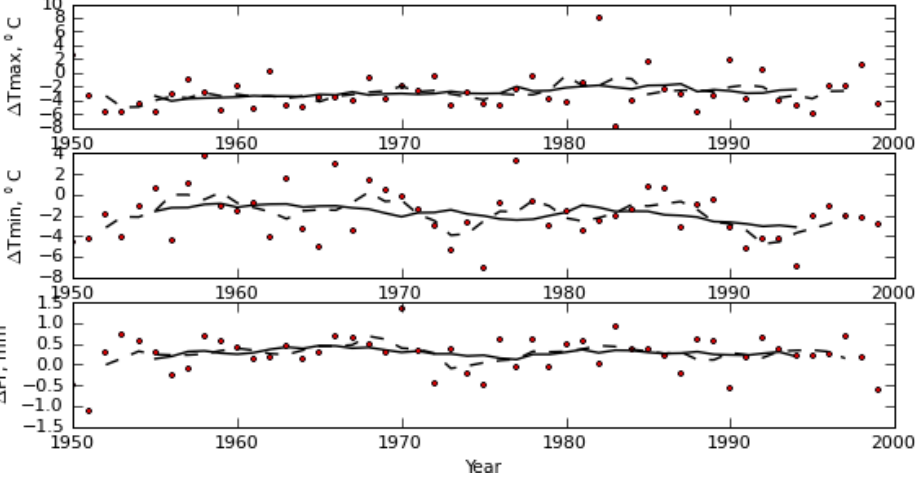
Fig. 8. Same as Fig. 7, for cell 17 (see Fig.